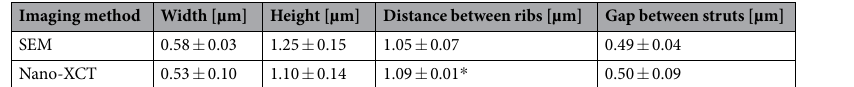
Table 3. Average dimensions with standard deviations of the ribs of the D. geminata cell structure marked in Figs 2, 4 and 6. * The distance between ribs is position 4 in Fig. 7.